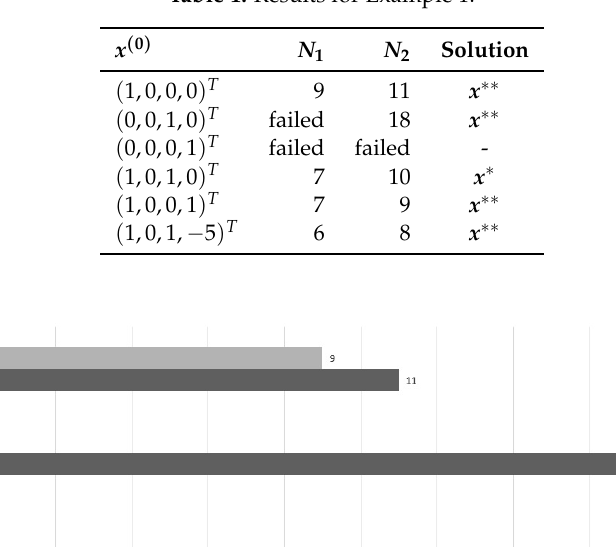
Table 1. Results for Example 1.